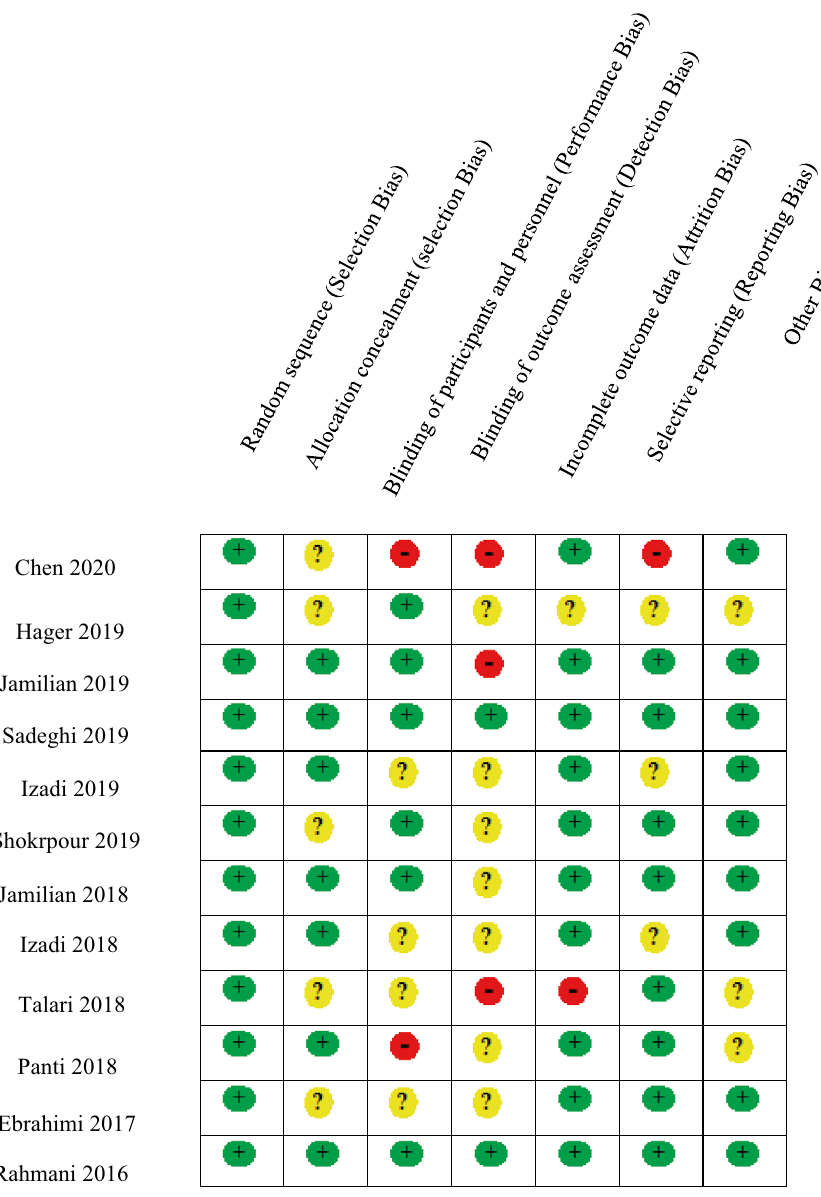
Figure 2. Assessment of the risk of bias in the included studies. Green circle (+): Low risk, Red circle (−): High risk, ?: